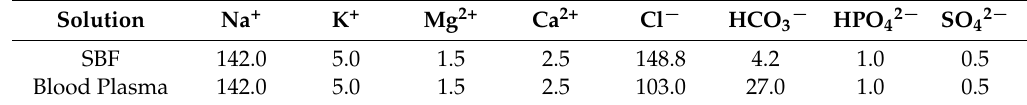
Table 1. Ion concentrations of simulated body fluid (SBF) and blood plasma (mmol/L).